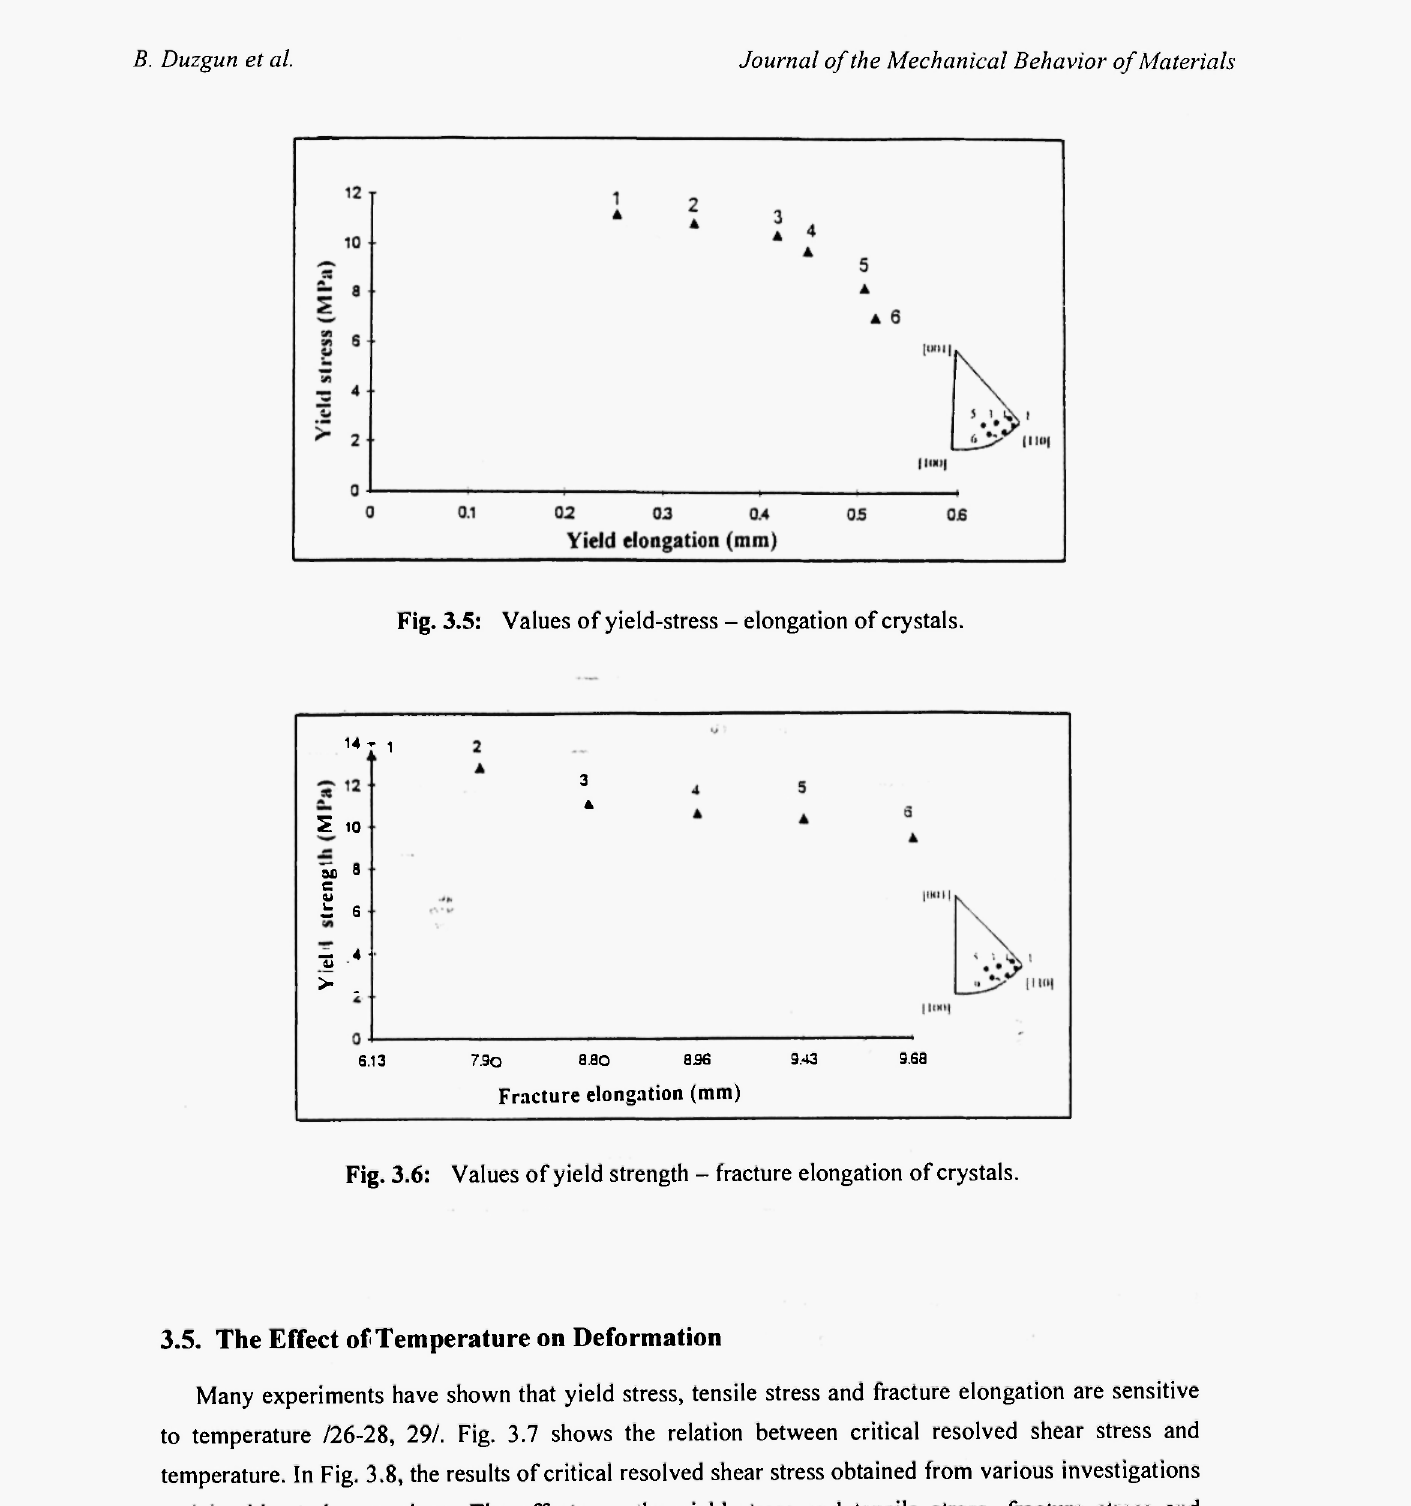
Fig. 3.6: Values of yield strength - fracture elongation of